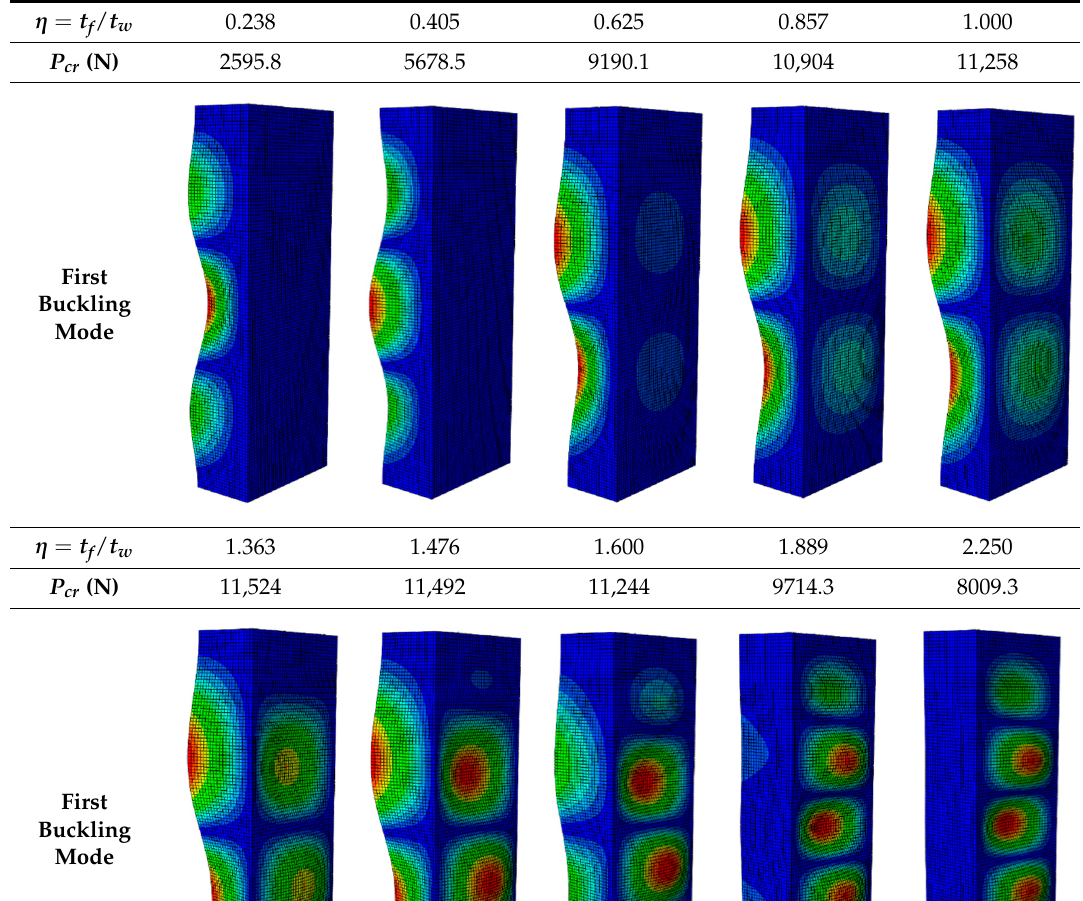
Table 5. First Buckling Modes of the Strut with Di ff erent Flange / web Thickness Ratios.